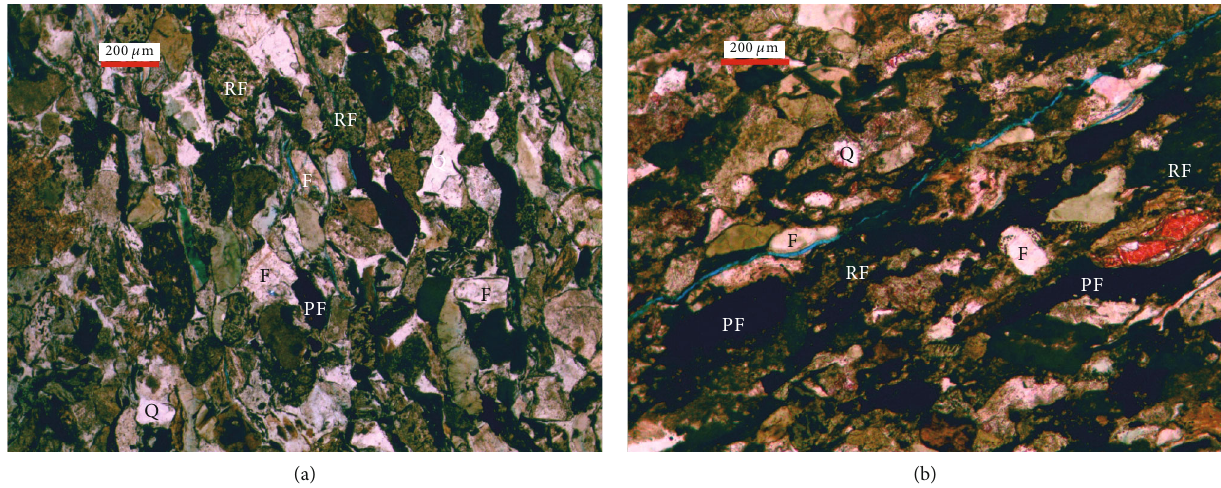
Figure 4: Photomicrographs showing mineral composition and texture of the Longtan sandstones. White grains are mostly quartz (Q) and feldspar (F); dark green grains are generally rock fragments (RF); dark blue grains are plant fragments (PF). Pores and microfractures are shown in blue. (a) Litharenite, fi ne grained, subangular to subrounded, moderate, YV-1-1, 810.85m, Longtan Formation, and plane- polarized light; (b) litharenite, fi ne to very fi ne grained, subangular, moderate sorting to poor sorting, YV-1-3, 681.11m, Longtan Formation, and plane-polarized